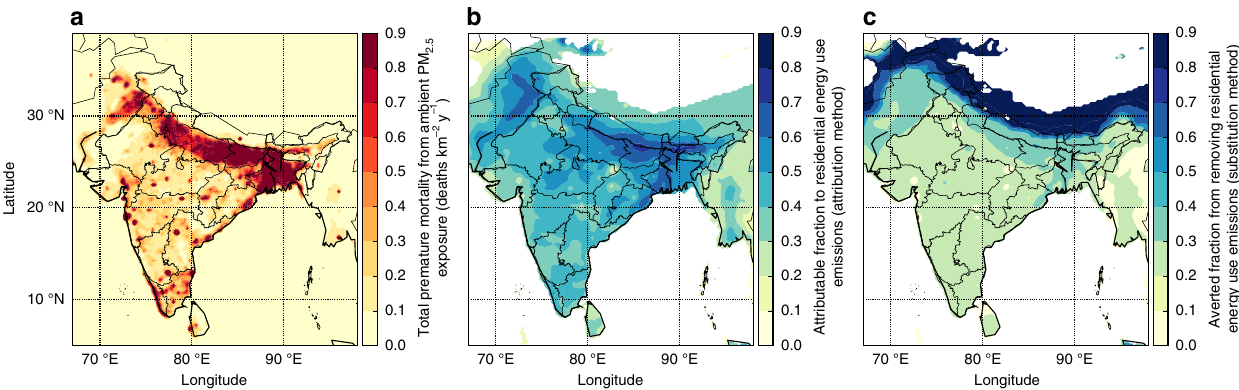
Fig. 3 Disease burden due to exposure to ambient PM 2.5 across India. a Estimate of annual premature mortality due to exposure to PM 2.5 in India. b Attributable fraction of premature mortalities from residential energy use emissions (attribution method). c Averted fraction of premature mortalities from removing residential energy use emissions (substitution